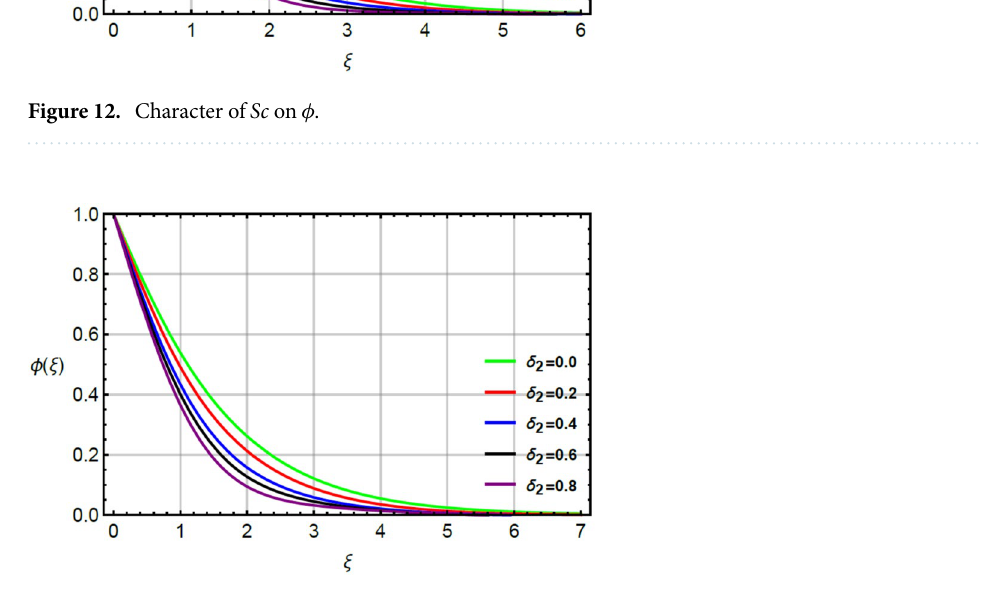
Figure 13. Character of δ 2 on φ